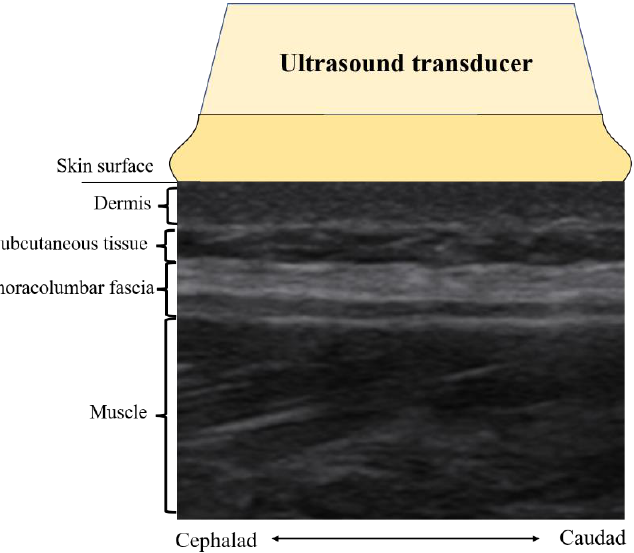
Figure 2. Example of a parasagittal ultrasound image.